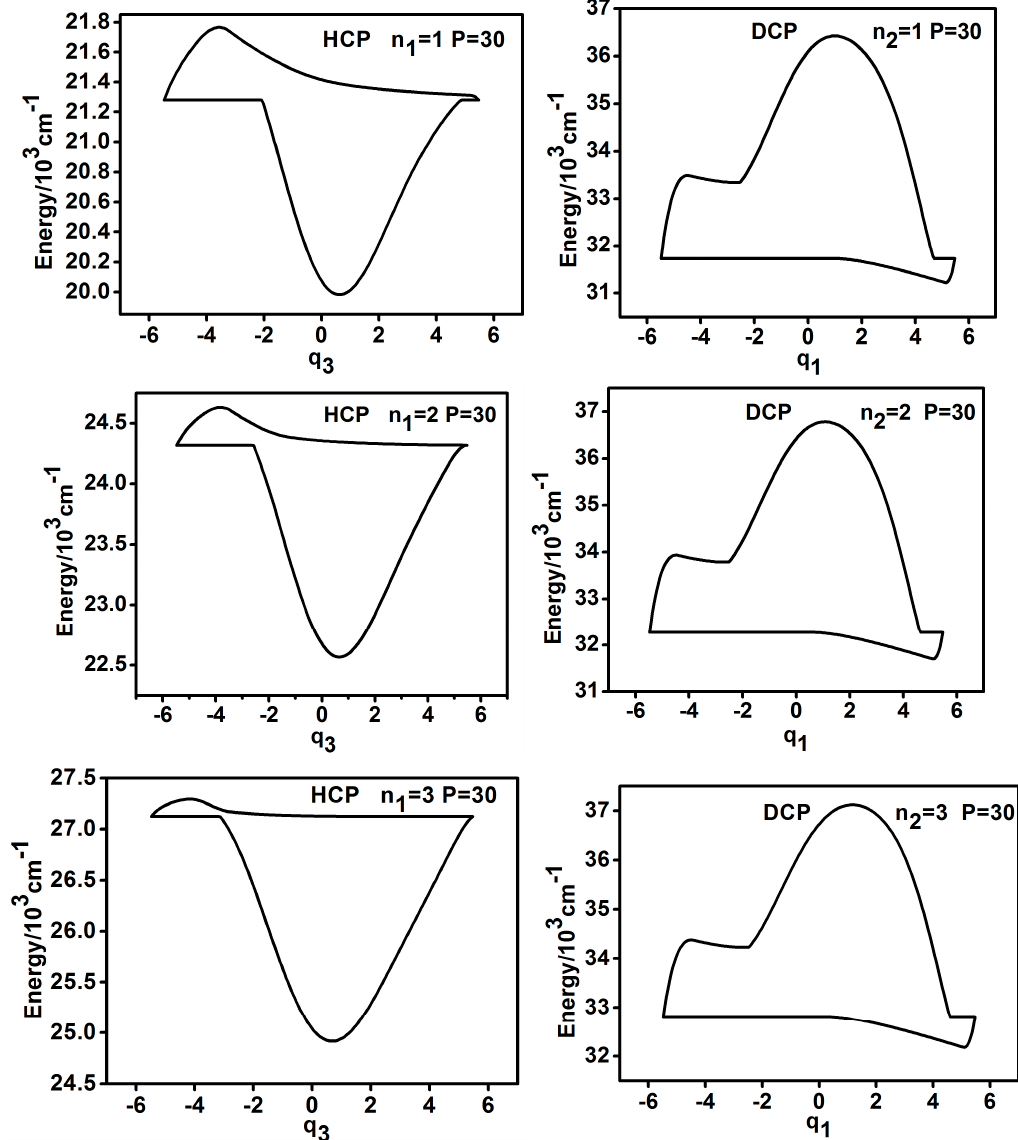
q ) and DCP ( 3 ) and DCP ( q 1 ) when n un > 0 ( P = 3